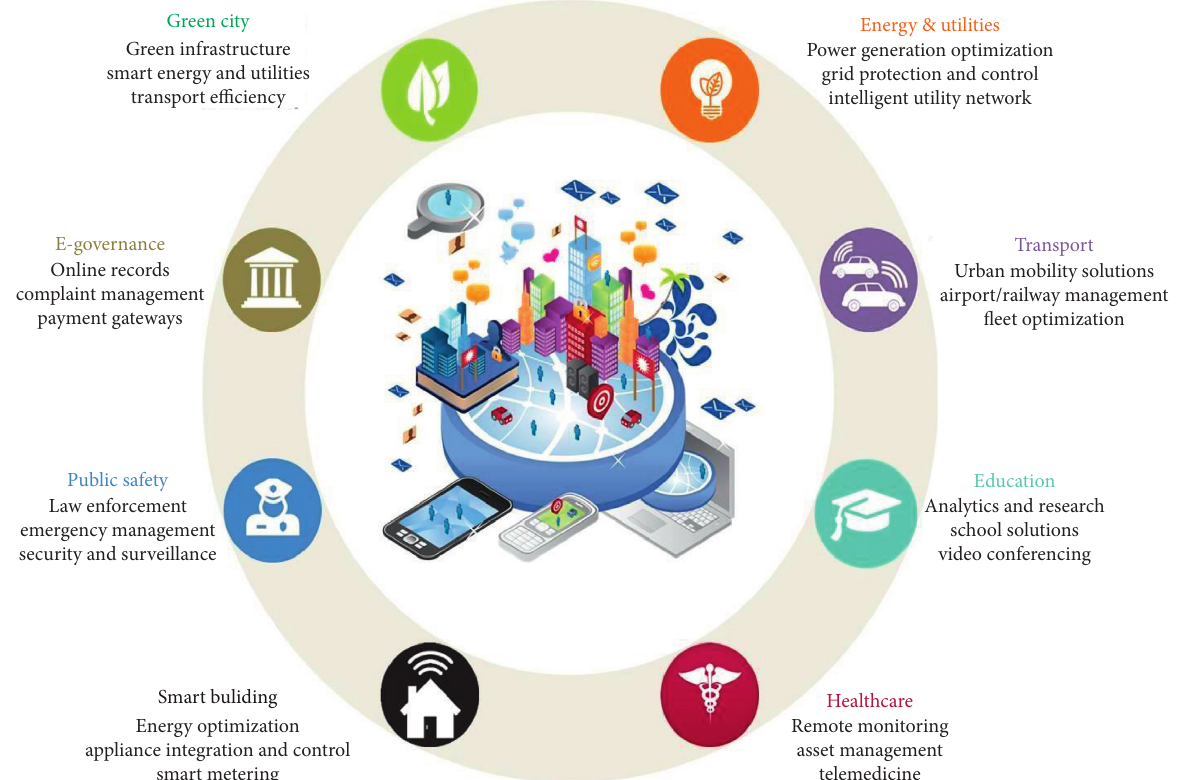
Figure 2: Smart cities and related entities.